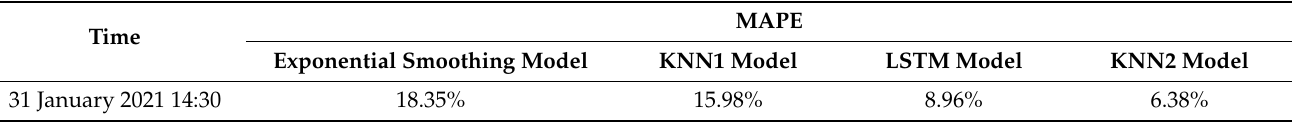
Table 4. Comparison table of prediction errors of online car-hailing demand by different models.